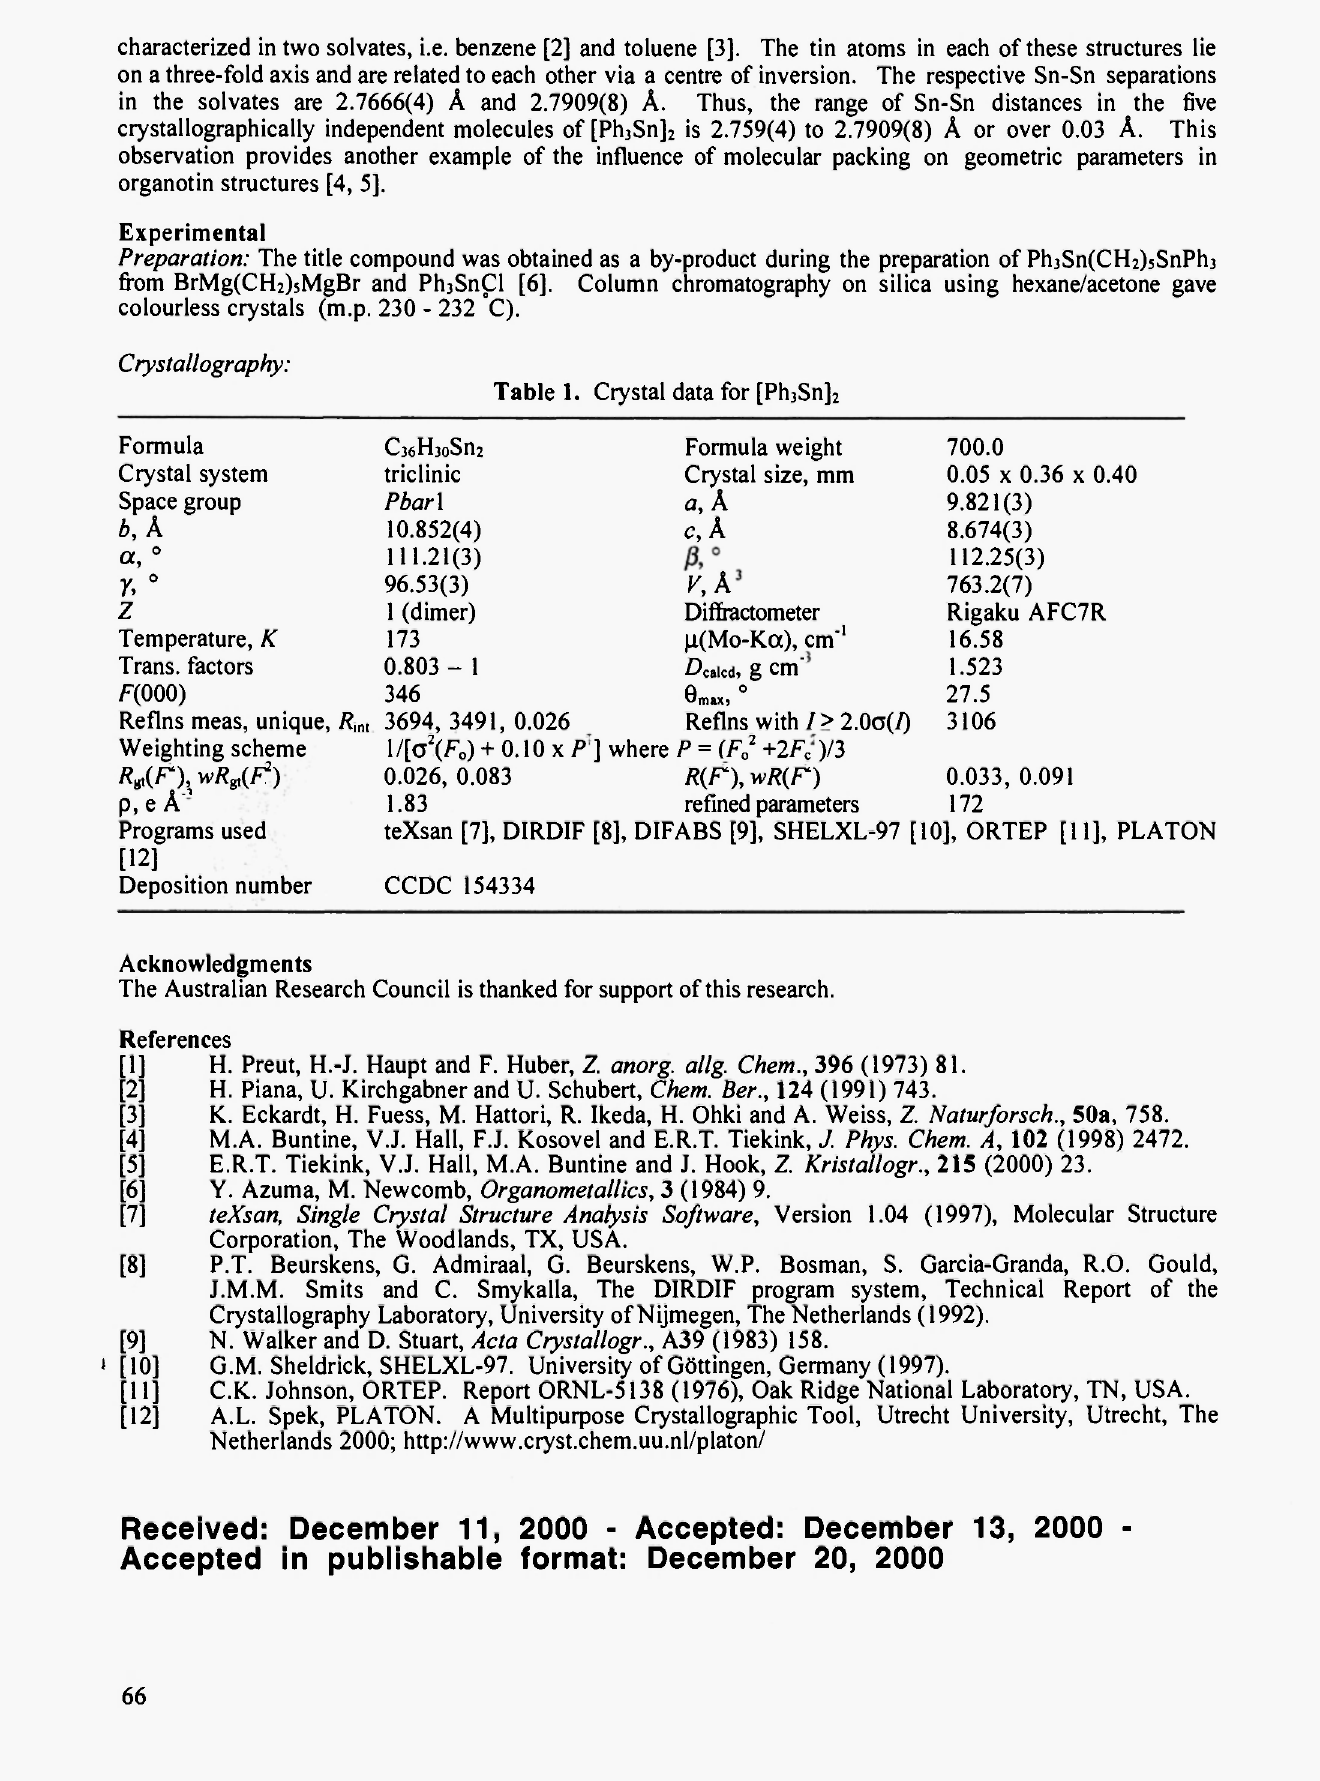
Table 1. Crystal data for [Ph 3 Sn]